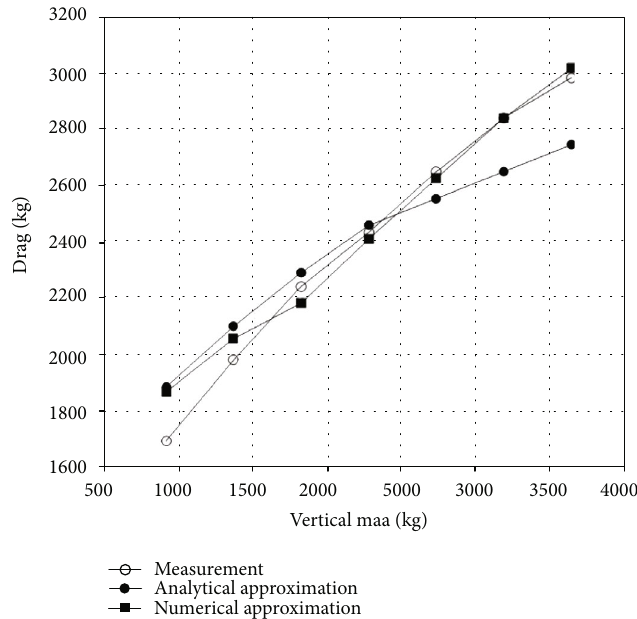
Figure 6: Comparison of the total drag between measurement, analytical results (both reprinted from [22]) and numerical results for the “ ground-hog ” .